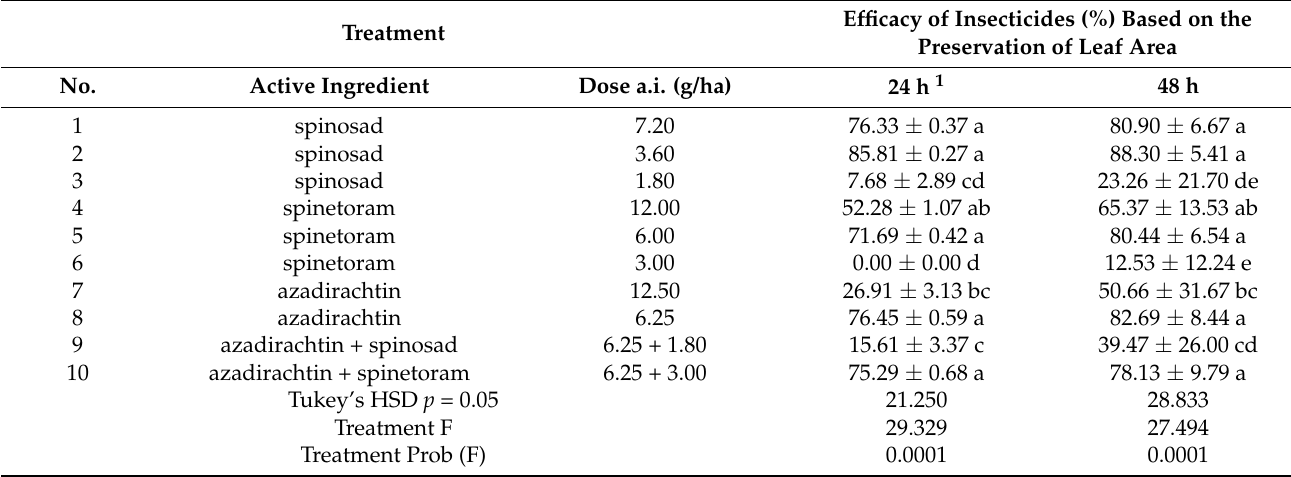
Table 5. Efficacy (%) of insecticides ( ± SE) on the preservation of potato leaf area in the first two days of the experiment.